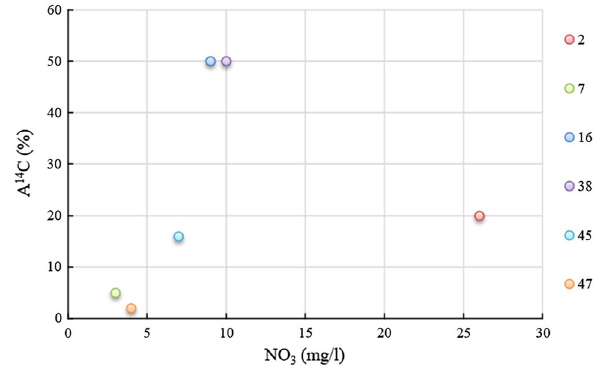
Fig. 7 Correlation NO 3− –A 14